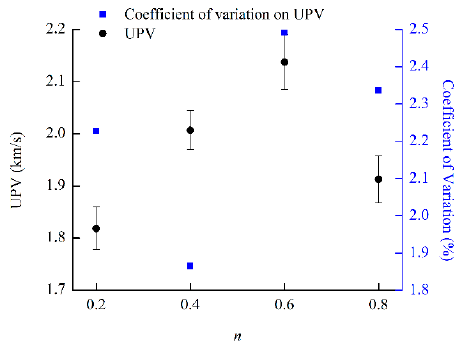
Figure 4. The dispersion of CPB specimens based on ultrasonic pulse velocity (UPV).